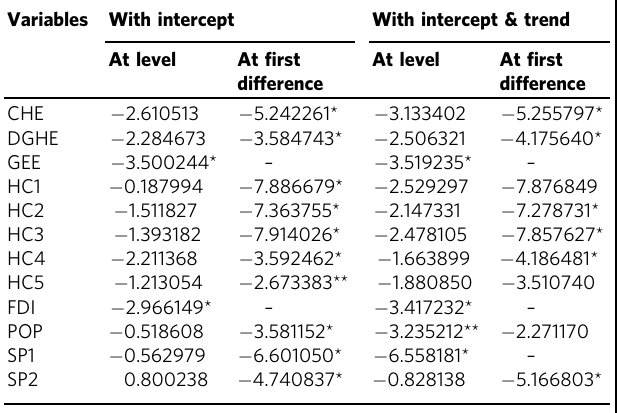
Table 1 Augmented Dickey – Fuller (ADF) unit root test.